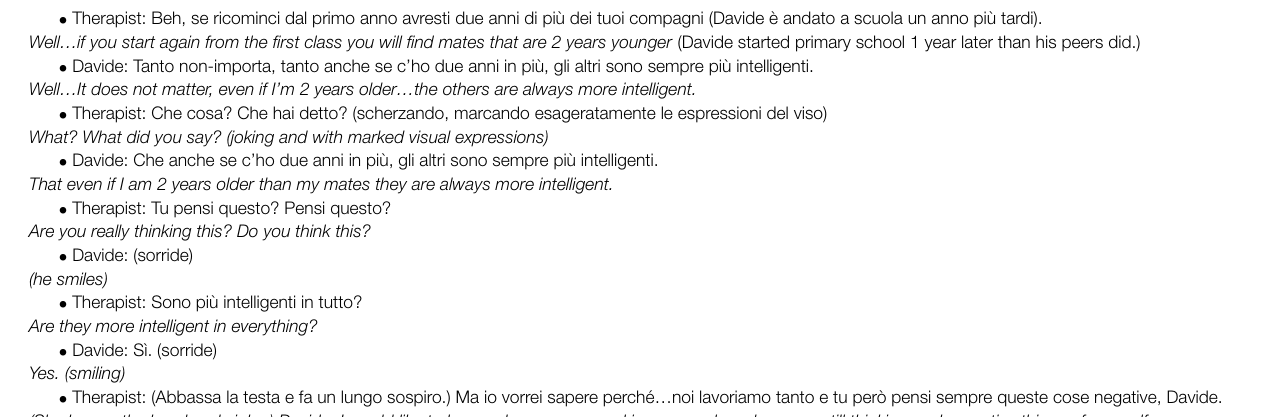
TABLE 6 | A dialogue between Davide and the therapist (MO). The excerpt is from a conversation focused on choosing a new professional high school after a first year in which Davide attended a professional school that he did not like. The doubt has to do with whether to move to the first-year class or second-year class of the new